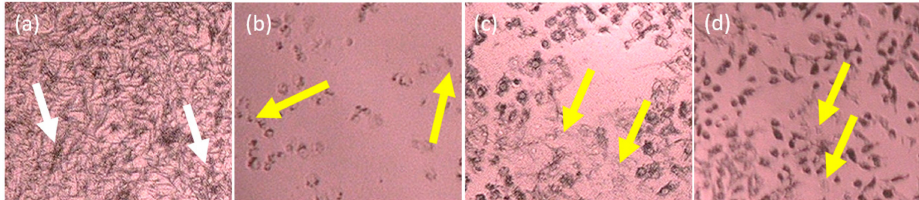
Figure 6. The Vero cell morphologies after and before treatment with three partitions as follows: ( a ) untreated cell, ( b ) AC n -hexane, ( c ) IC n -hexane, and ( d ) IC ethylacetate. The white arrows indicate the normal living cells that form formazan crystals whereas the yellow arrows indicate the dead